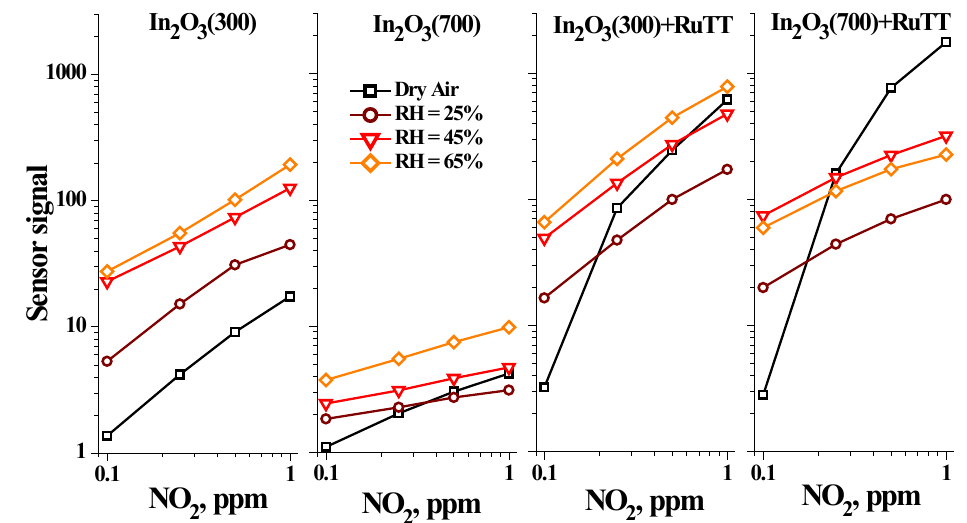
Figure 10. Dependence of the sensor signal of In 2 O 3 (300), In 2 O 3 (700) samples and hybrid materials based on them on the NO 2 concentration at different air humidity (relative humidity at 25 °C RH = 25, 45, 65%).